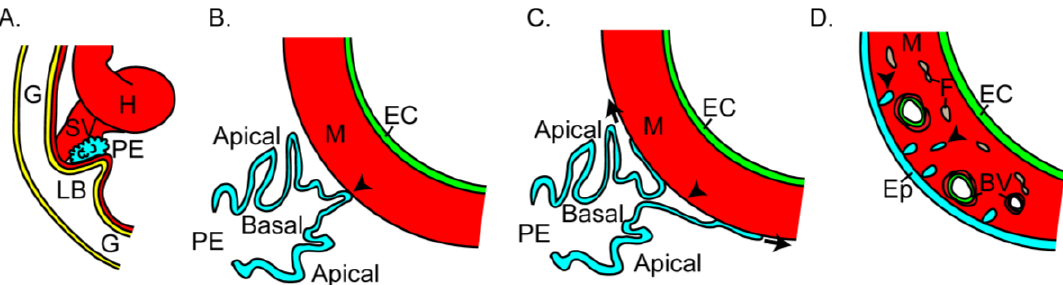
Figure 5. Proepicardium (PE) development. ( a ) The PE (blue) forms external to the heart tube as an outgrowth from the region of the sinus venosus (SV) and liver bud (LB). ( b ) The PE epithelium is polarized with apical toward the pericardial space. The PE crosses the pericardial cavity to contact (arrowhead) the myocardium (M). ( c ) At points of contact with the myocardium, the PE epithelial sheet breaks open (arrowheads) to preserve apical-basal polarity and migrate over the heart tube (arrows). ( d ) During migration and after a continuous epicardium (Ep) is formed, cells leave the epicardium (arrowheads) via epithelial to mesenchymal transition (EMT) to migrate into the myocardium and generate fibroblasts (F) and the coronary blood vessels (BV). EC, endocardium; G, gut tube; H, heart